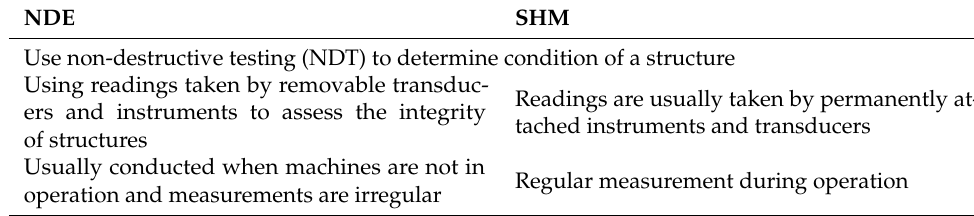
Table 5. A comparison of NDE and